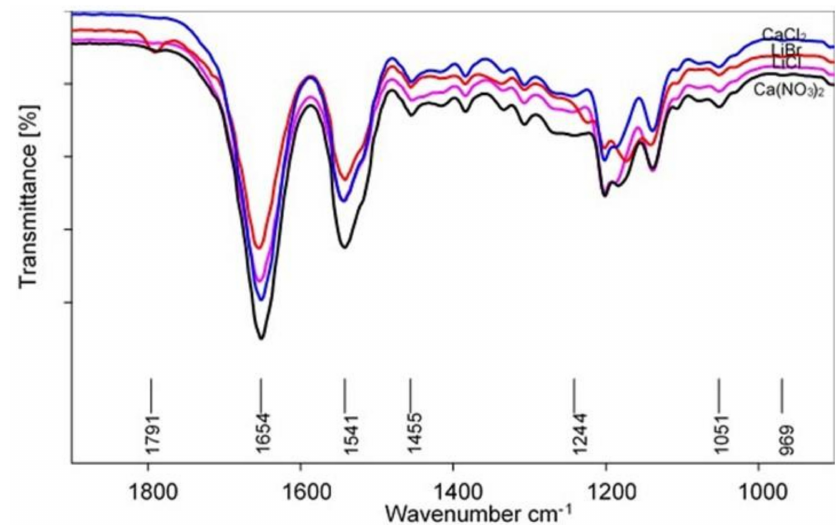
Figure 16. FTIR spectra for electrospun nanofibers.